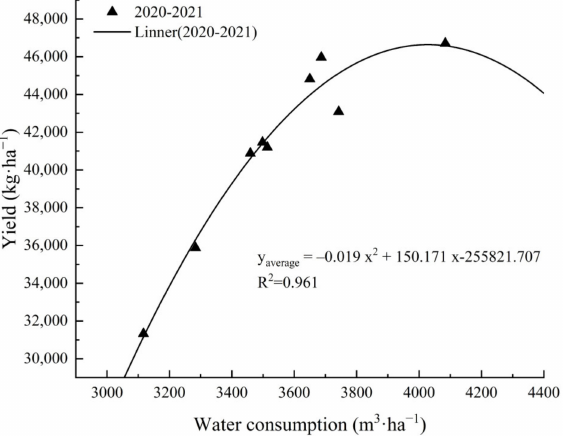
Figure 6. Relationship between consumption and yield of